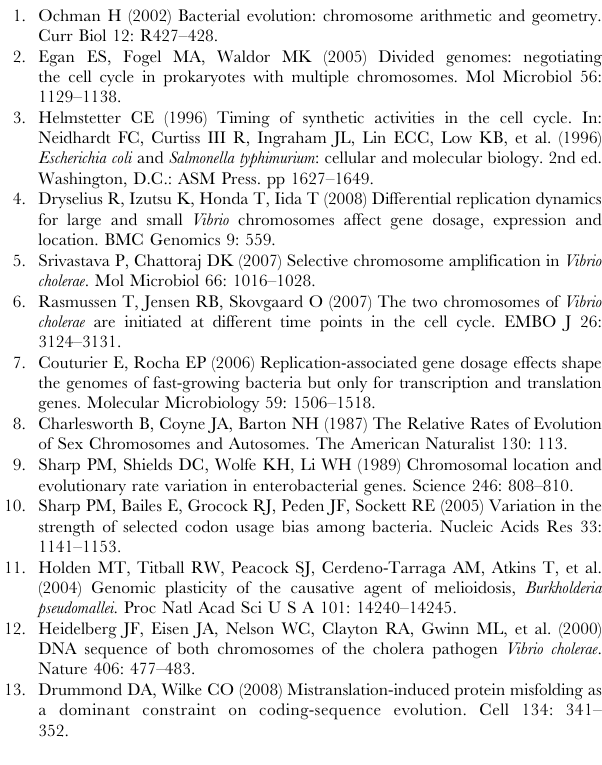
Table S8 Analyses of variance among evolutionary rates of primary and secondary panorthologs shared between Burkholderia and Bordetella . Bordetella dS results were omitted because they are too high to be reliable. Table S9 Distribution of panorthologs shared by Burkholderia and Bordetella by chromosome location in Burkholderia and COG annotation. Table S10 Analyses of variance of the rates of nonsynonymous substitutions among primary and secondary panorthologs shared between Vibrio and Xanthamonas . Estimates of rates of synonymous substitutions were omitted because they are too high to be considered